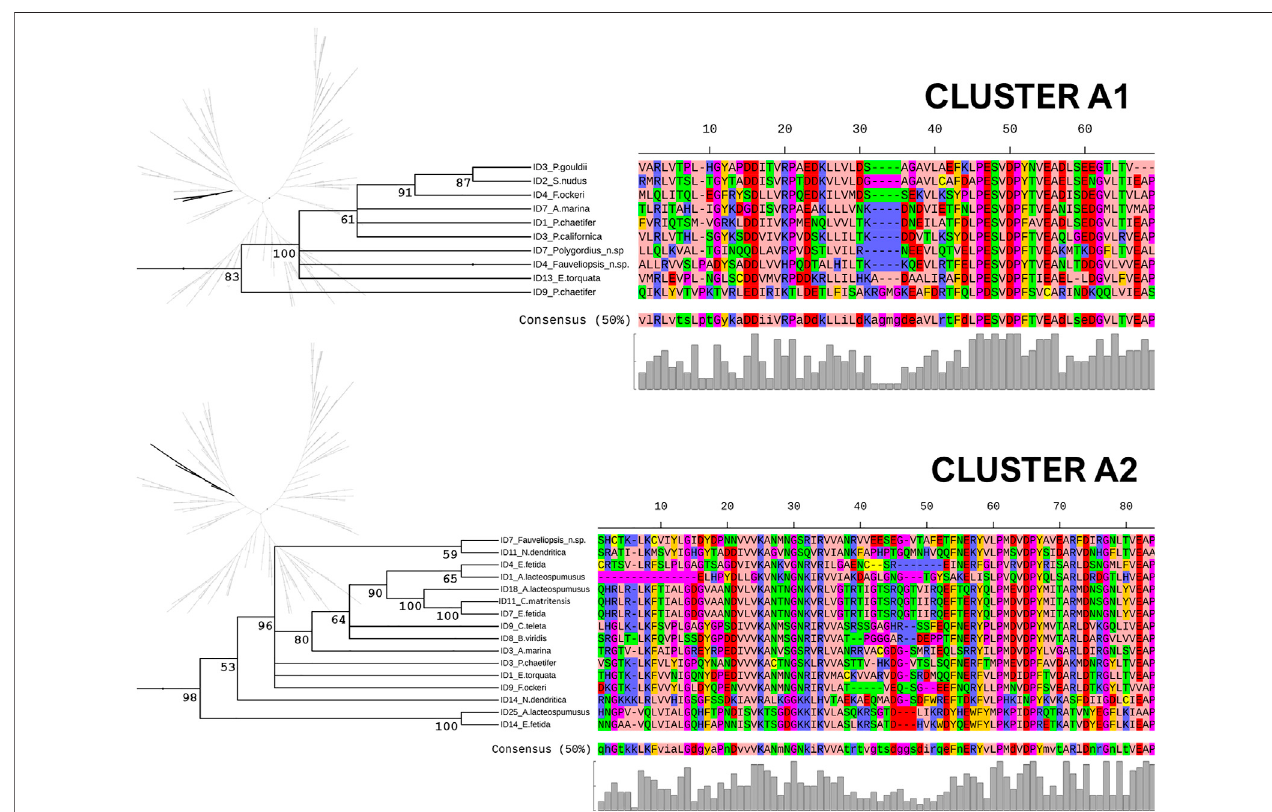
FIGURE5| ClustersA1and A2.Multiple sequence alignment visualizedon adendrogram obtainedfrom theBayesiantree,using theZappo coloringscheme. The consensus sequence (at 50% conservation) and residue conservation were calculated by iTOL. On the left, the unrooted radial ML cladograms, in which each cluster is highlighted. The posterior probability values are included as percentages in the